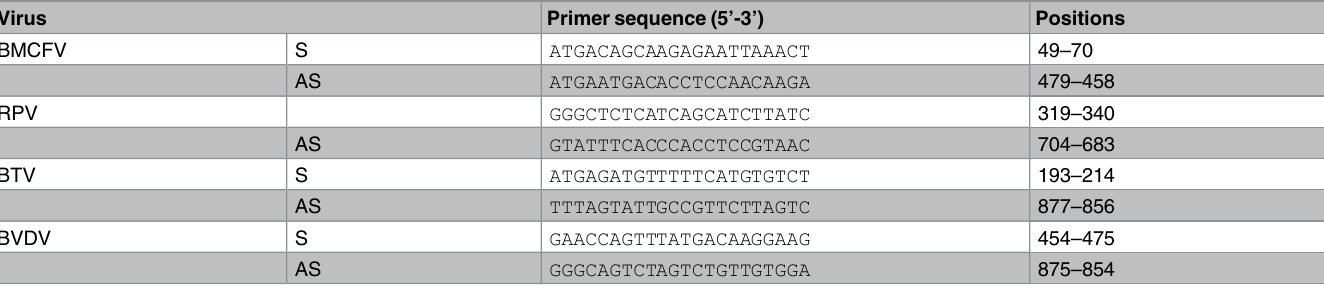
Table 1. Primers used for detection of potential